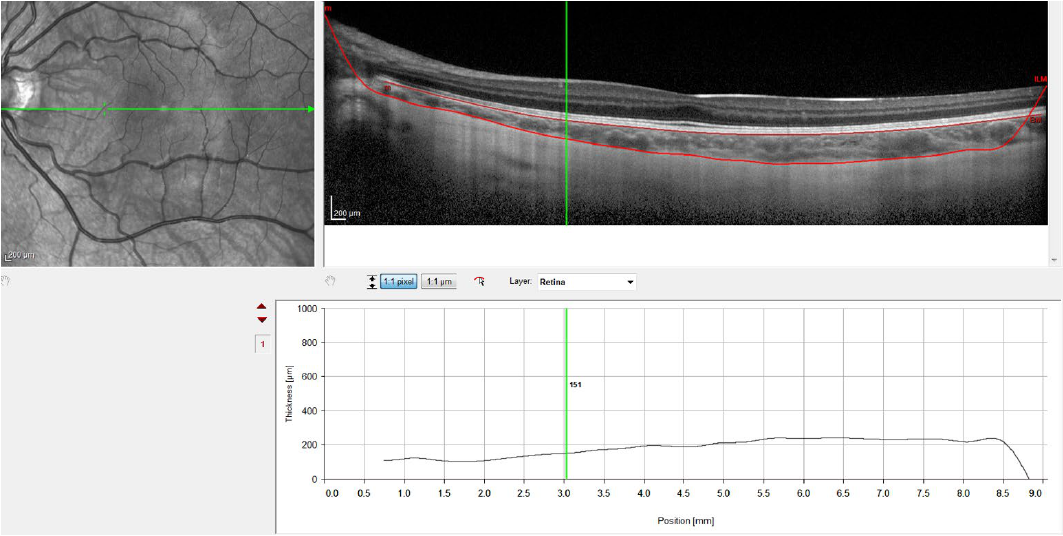
Figure 4. OCT image with lines in red corresponding to the retinal pigment epithelium and the sclero-choroidal interface.